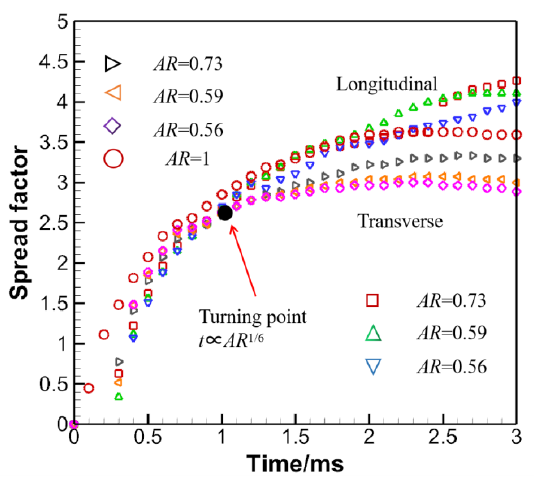
Figure 15. Comparison of spread factors of distinct ARs in different tracking directions.